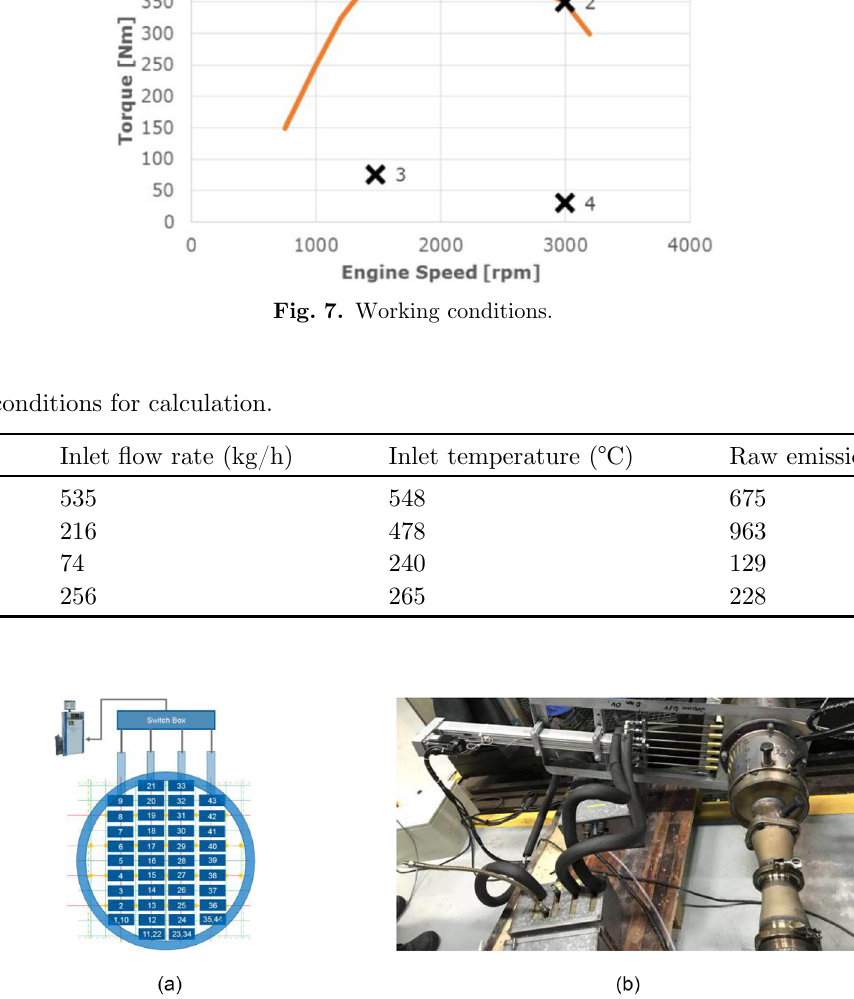
Fig. 8. Gas analyzer. (a) Schematic diagram of ammonia analyzer. (b) Installation diagram of ammonia